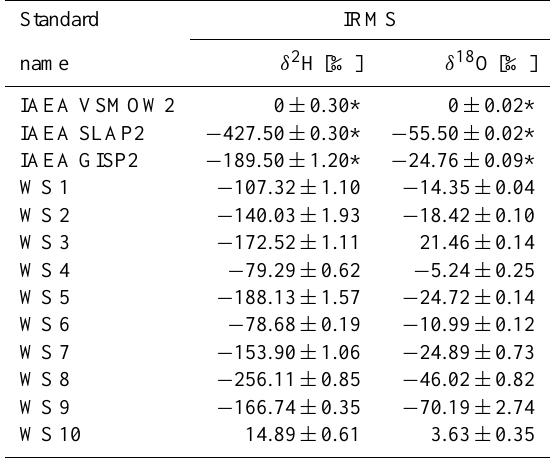
Table 2. Isotopic composition (in ‰) of the international IAEA standards and working standards (WS) used for the characterisa- tion of the laser systems. The indicated isotopic δ values of working standards 1–10 were measured with